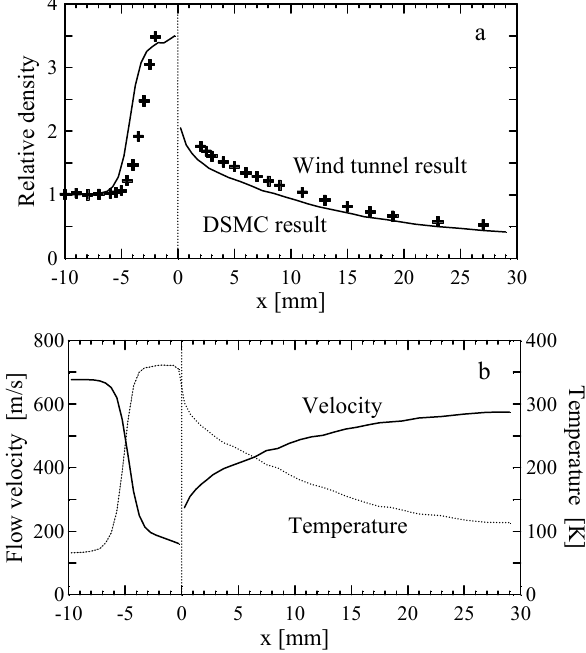
Fig. 3. Flow conditions along the symmetry axis in Fig. 2. (a) Mea- sured and simulated density, (b) simulated temperature and axial velocity